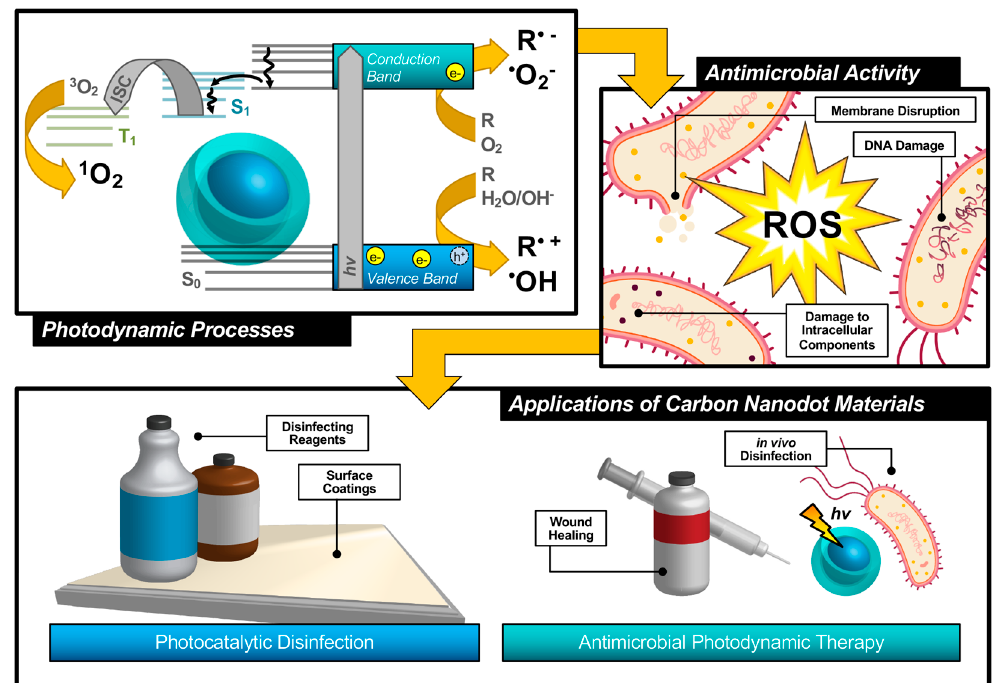
Figure 1. Schematic description of antimicrobial photodynamic therapy and photocatalytic disinfection using carbon nanodots.